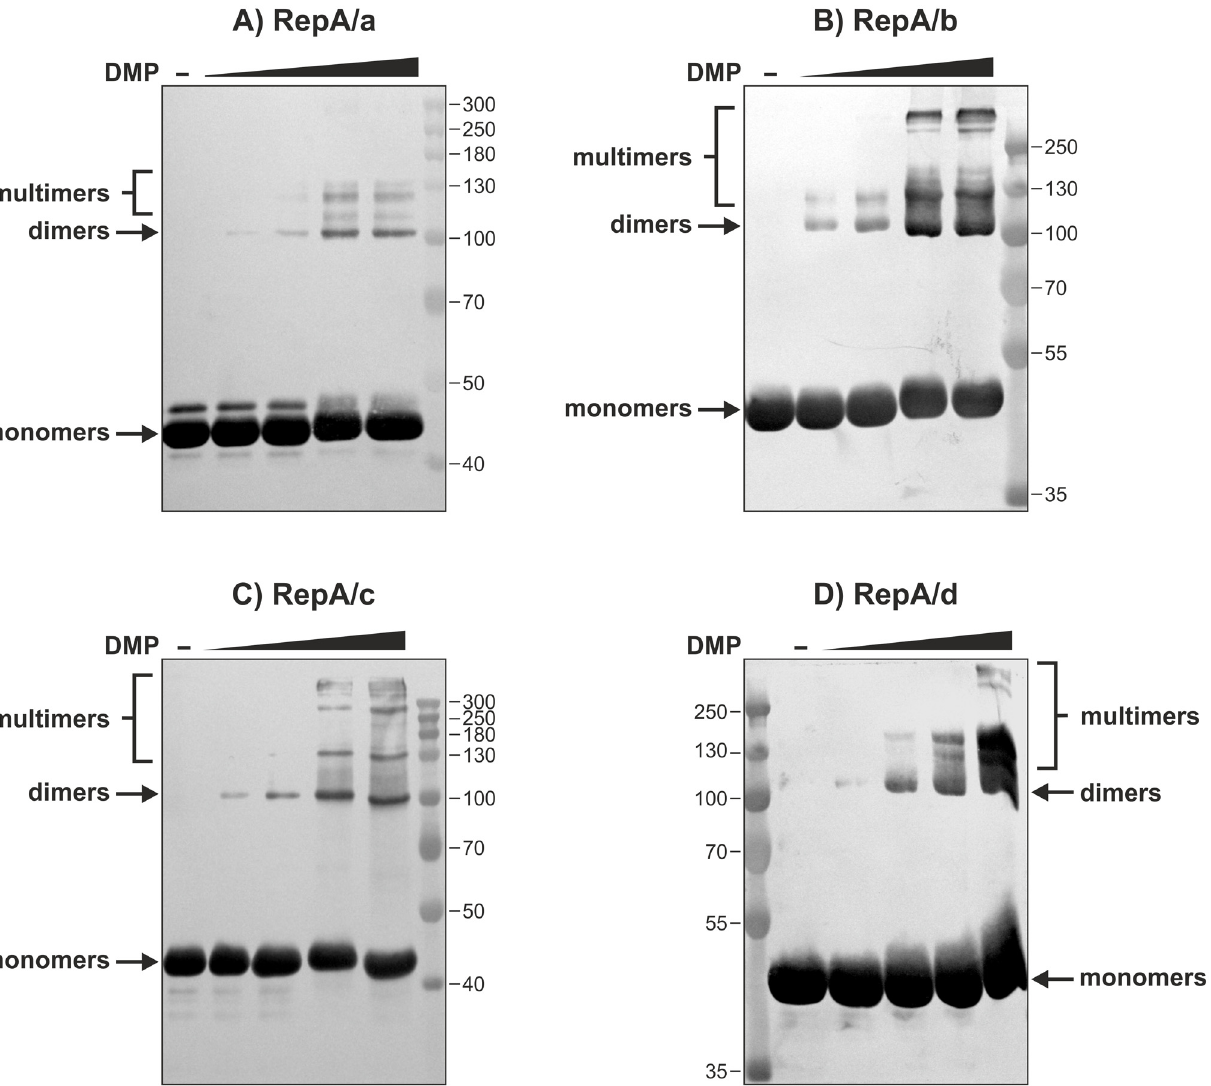
Fig 6. Cross-linking analysis of His 6 -RepA/a-d. His 6 -tagged RepA proteins (0.1 – 0.2 nM) were incubated with increasing concentration of DMP (0.5 mM, 1 mM, 10 mM, and 25 mM), separated on 10% SDS-PAGE and visualized by Western blot with anti-His 6 antibodies. The thin lines indicate the marker bands whose molecular masses are expressed in kDa. Arrows indicate different species formed by RepA proteins corresponding to monomers and dimers, while the position of multimers was marked with